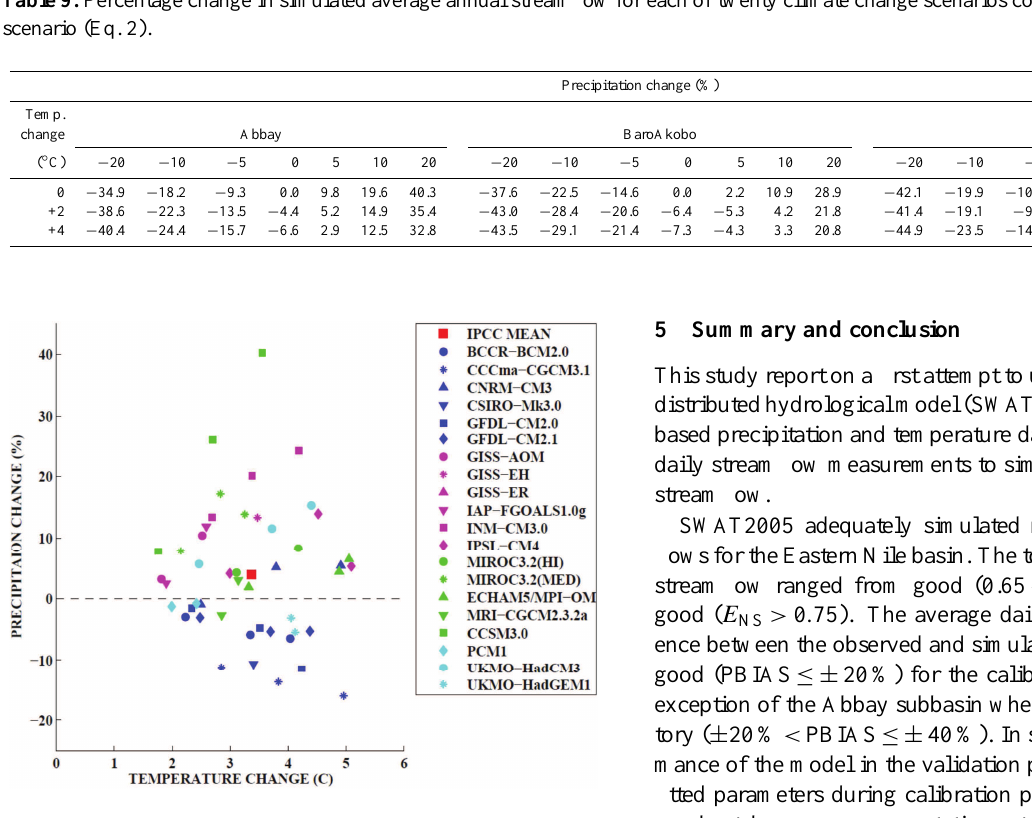
Fig. 11. Change in temperature ( ◦ C) and precipitation (%) for the Figure 11: Change in temperature (°C) and precipitation (%) for the period 2081-2100 period 2081–2100 compared to 1981–2000 from 19 AOGCMs and compared to 1981-2000 from 19 AOGCMs and three emission scenarios (totally 47 three emission scenarios (totally 47 simulations). Red square indi- simulations). Red square indicates the mean change over all simulations. cates the mean change over all